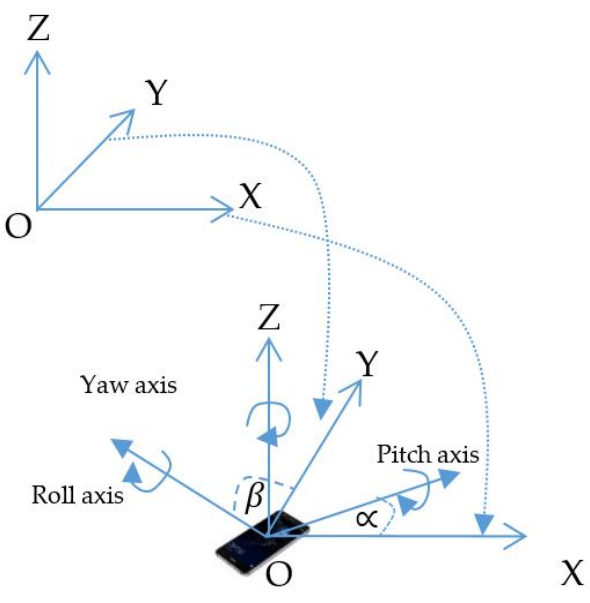
Figure 4. Image plane rotation scenario.